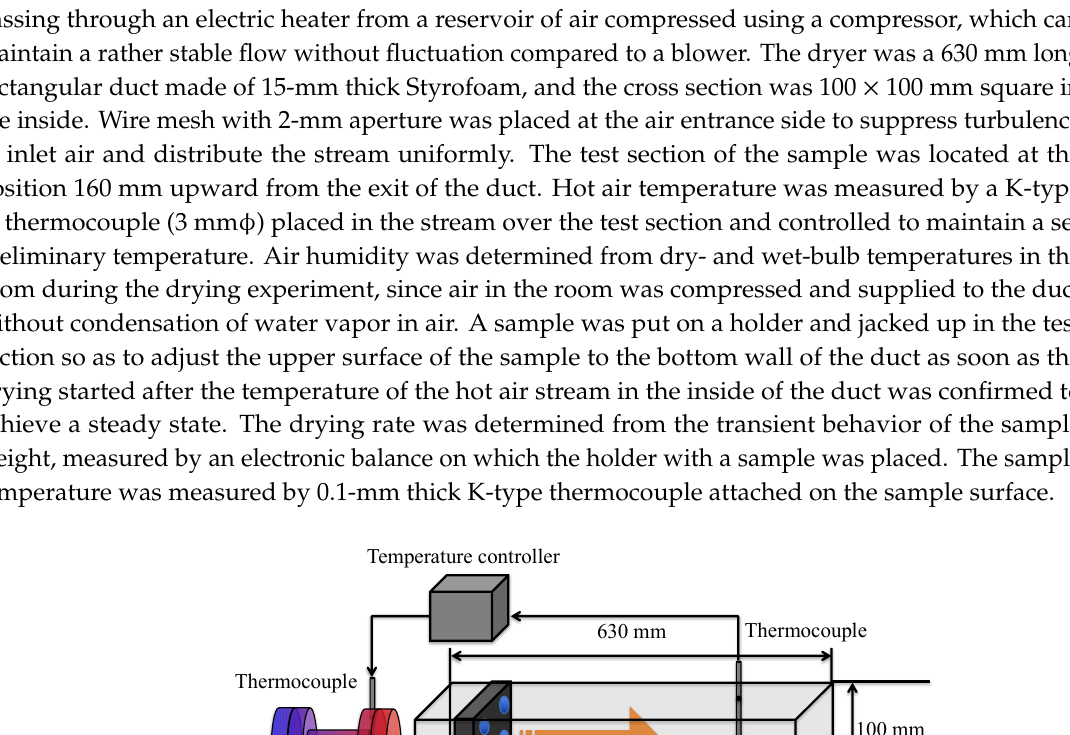
Figure 4. Outline of hot-air drying experimental setup (both sides drying of sample).